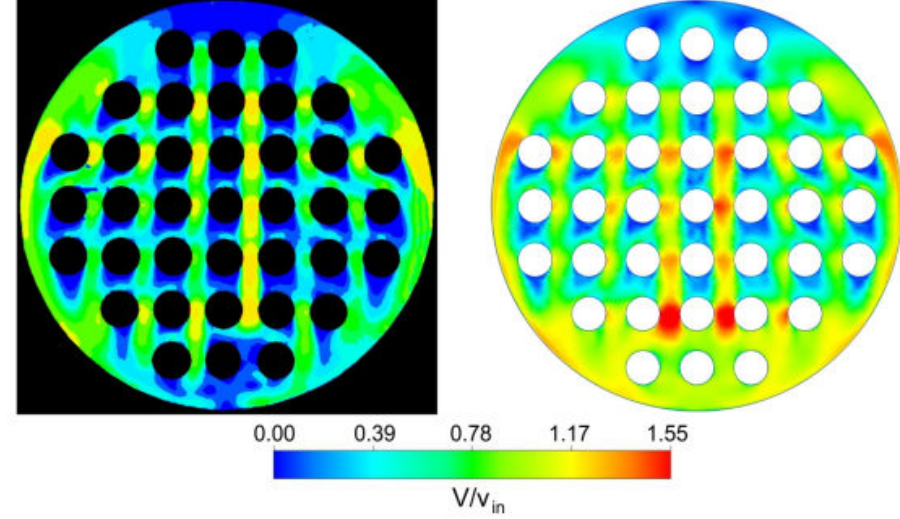
Figure 10. Comparison of scalar velocity fields V / v in for Q = 5m 3 / h (CFD on the right, PIV on the